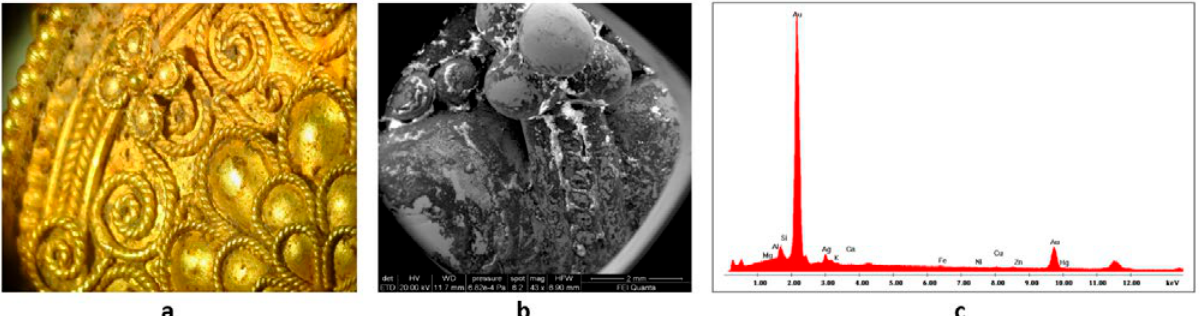
Figure 3. a) part of a modern jewel made of watermark; b) SEM image in secondary electrons of a part of the decoration; c) EDS analysis of the substance distributed on the